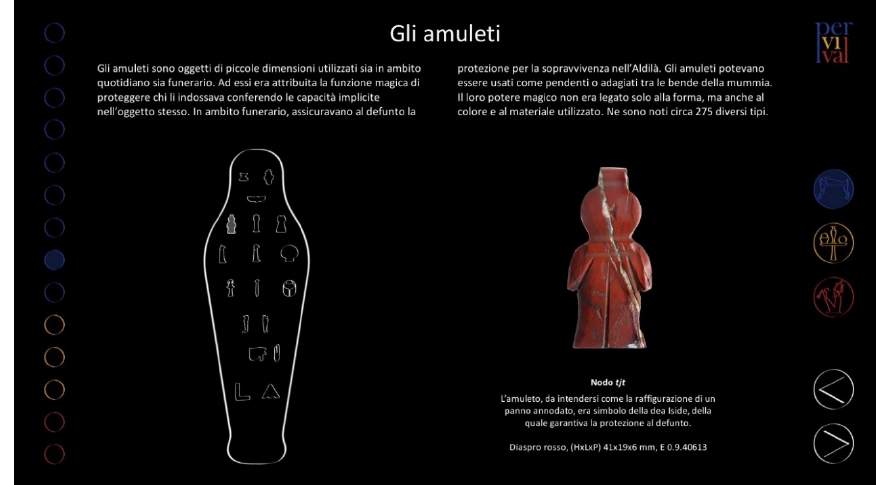
Figure 7. Digital app interface showing an example of the navigation Level II page with the main description of the single items. In the amulets page, the detailed information about the individual amulets is visible by scrolling through them on the right or by selecting the icon on the mummy map.